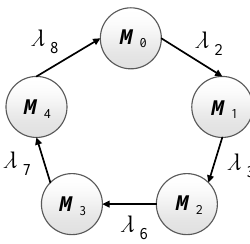
Figure 6. Isomorphic Markov